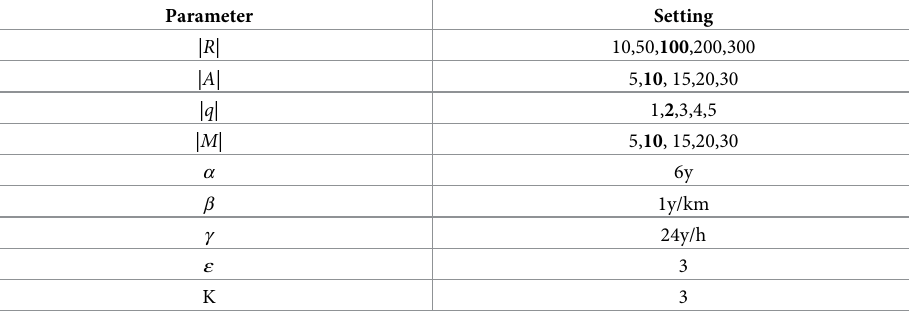
Table 4. The parameter settings for synthetic data.